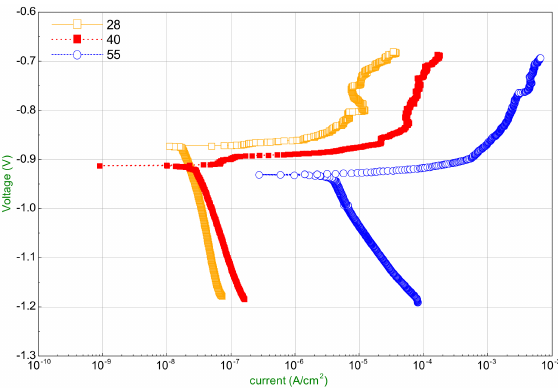
Figure 14. Corrosion characteristics of anodized aluminum plate under different solution